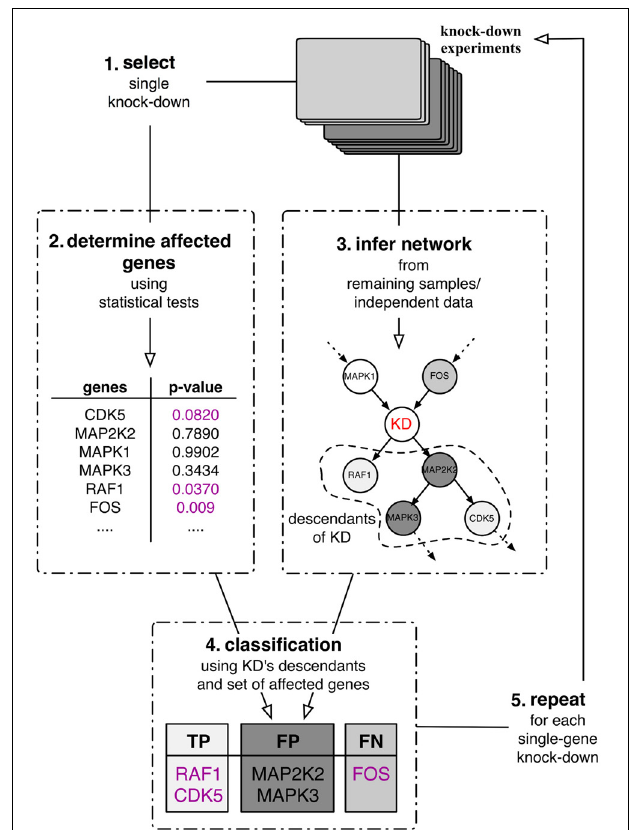
FIGURE 1 | Quantitative validation framework for network inference. The framework relies on a set of single-gene knock-down experiments in a leave-one-out cross-validation